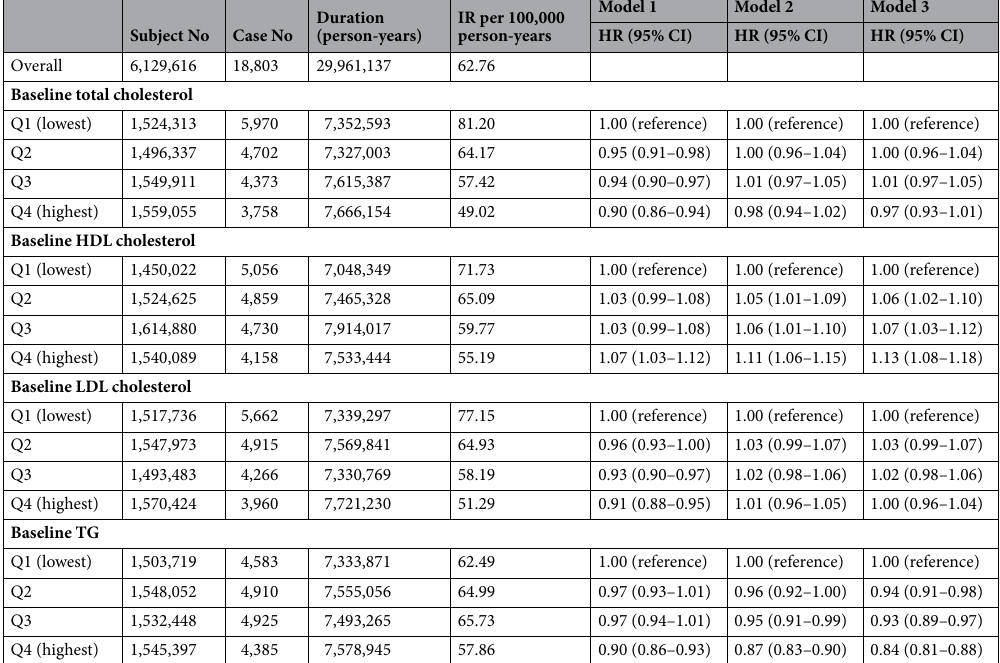
Table 2. Hazard ratios and 95% confidence intervals for development of exudative age-related macular degeneration according to baseline lipid profile. IR incidence rate, HR hazard ratio, CI confidence interval, Q quartile, HDL high-density lipoprotein, LDL low-density lipoprotein, TG triglycerides. Model 1: adjusted for age and sex. Model 2: adjusted for demographic factors (age, sex, income level), and systemic comorbidities (hypertension, diabetes mellitus, stroke, heart disease, chronic kidney disease, and dyslipidemia medication). Model 3: adjusted for demographic factors, systemic comorbidities, and behavioral factors (smoking history, drinking habits, physical activity, and body mass